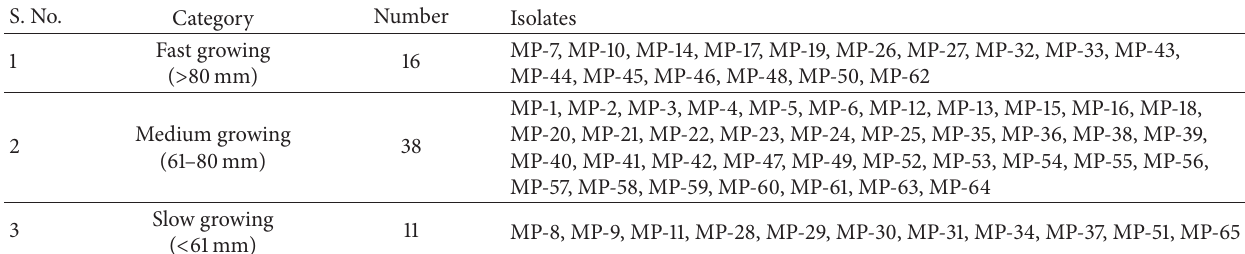
Table 3: Categorization of M. phaseolina isolates on the basis of radial growth.